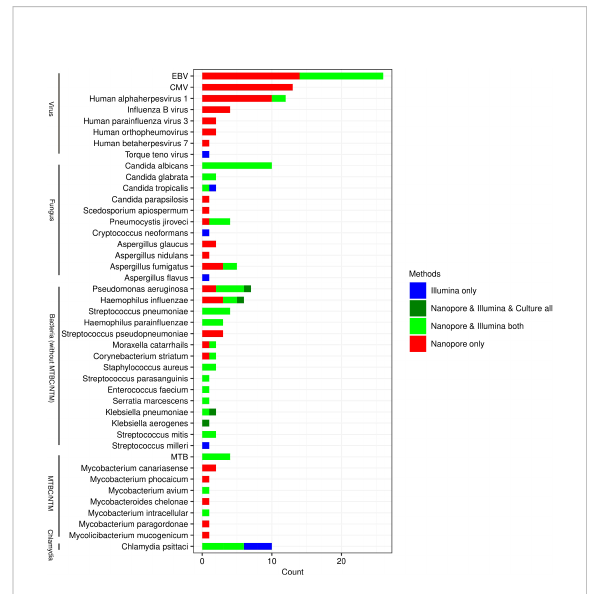
FIGURE 2 The consistency of pathogens detected by Illumina, Nanopore and culture.